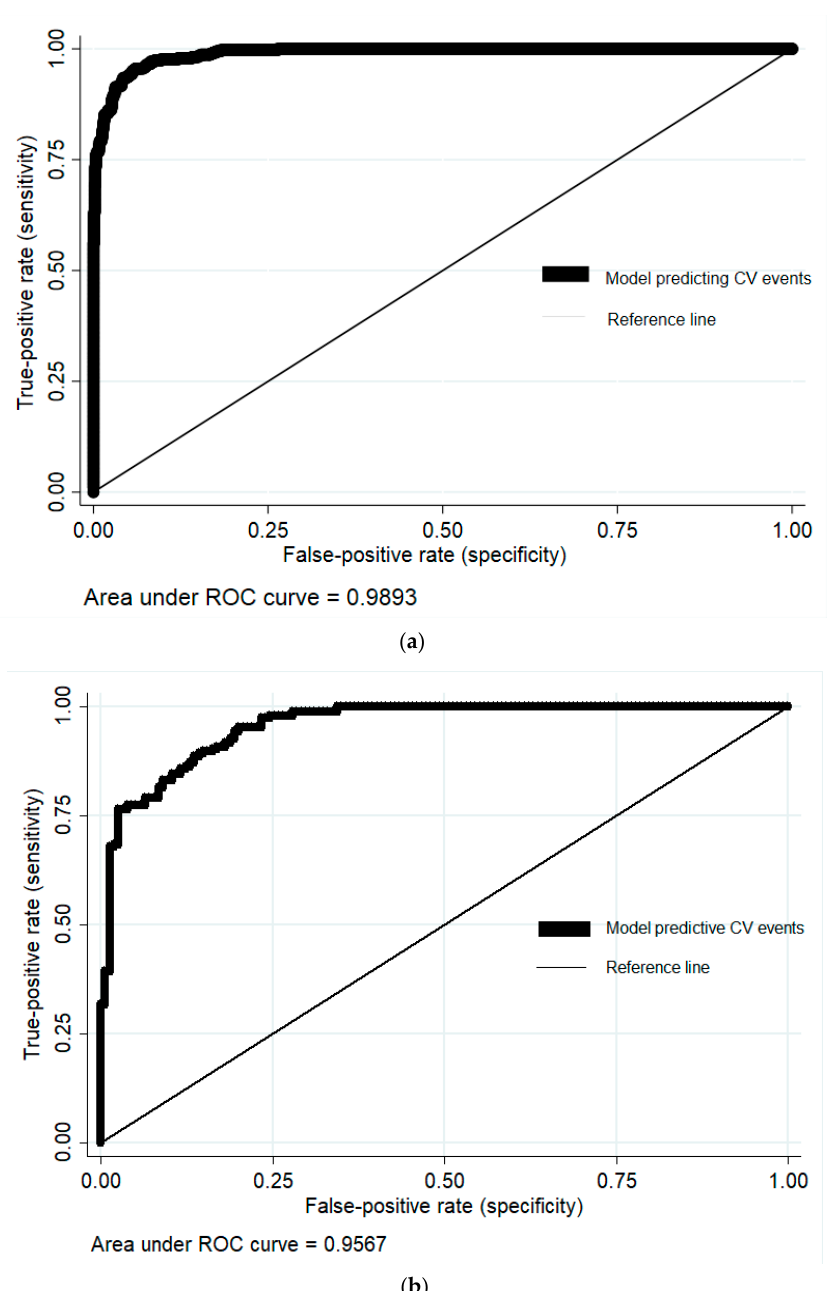
Figure 2. ( a ) Receiver operating characteristics (ROCs) curve for the diagnosis of cardiovascular (CV) events using the development cohort. Area under the ROC curve yielded a value of 0.989 suggesting excellent discrimination between CV events vs. no events. Variables included male sex, Af-